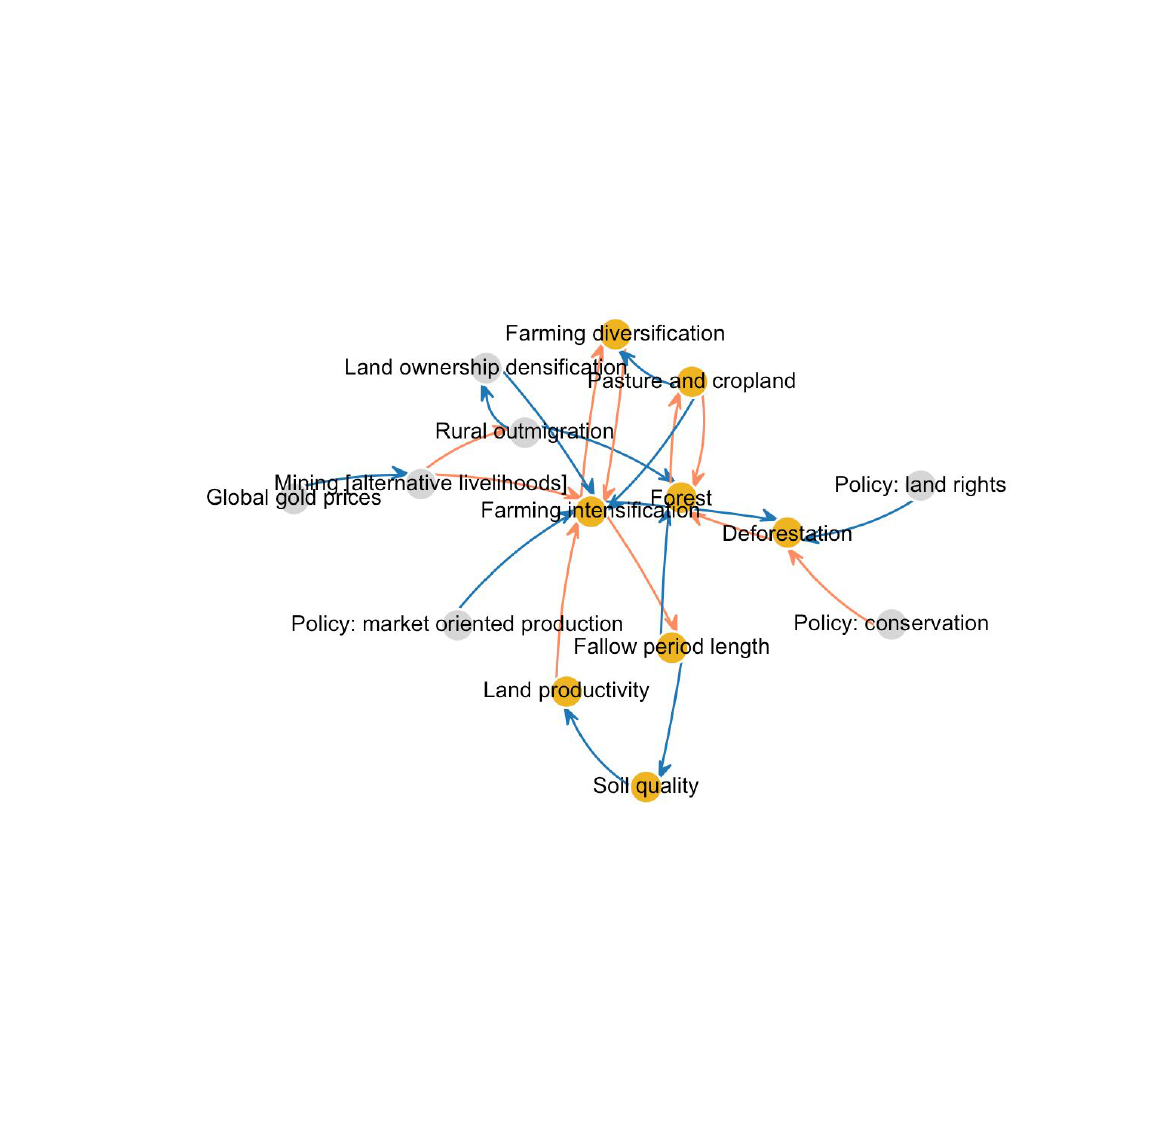
Figure A1.7. CLD expansion of small-scale agriculture and ranching,Pará, ​​